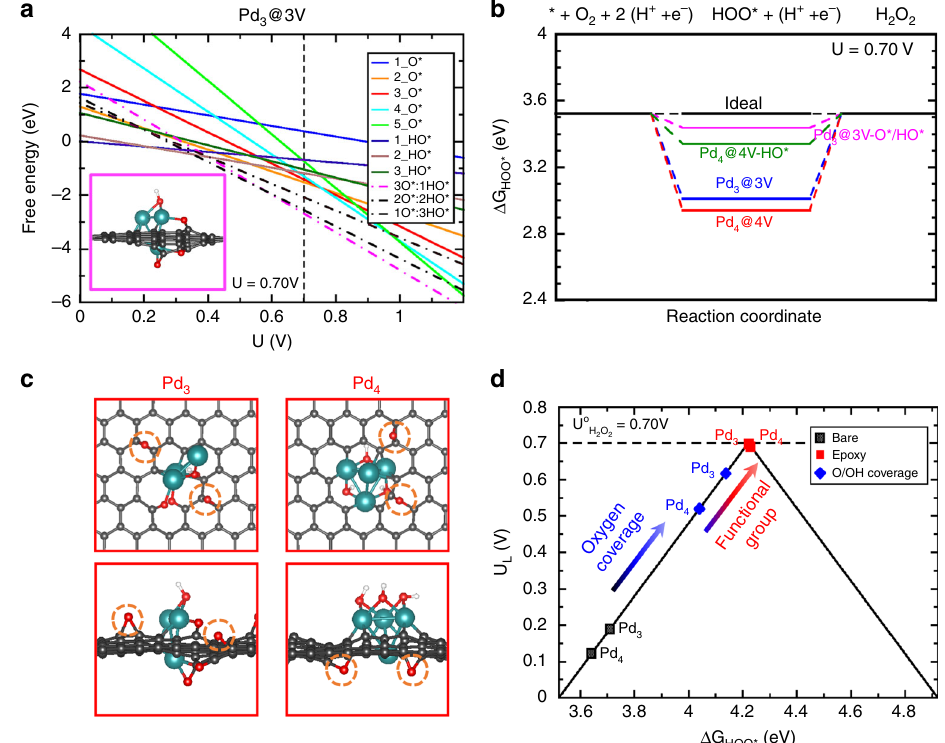
Fig. 5 DFT calculations of ORR activity and selectivity on different motifs. a Pourbiax diagram for determining the steady state coverage of the oxygenated species on Pd 3 under 2e - ORR standard redox potential (0.70 V). The inset shows the side view of the most stable coverage. Color code for the atomic structure; C: gray, O: red, Cyan: Pd. b Free energy diagram for 2e - ORR over the most stable structure from Pourbiax analysis at 0.70 V. c Optimized DFT model structures with nearby epoxy functional groups (highlighted by orange dashed circles) on the most stable O*/HO* covered Pd 3 and Pd 4 clusters. d Activity volcano plot, the y axis is the calculated limiting potential (U L ), de fi ned as the maximum potential at which the reaction steps become downhill in free energy. The x axis is the calculated free energy of HOO*. Horizontal dashed line is the standard redox potential for the 2e - ORR (0.70